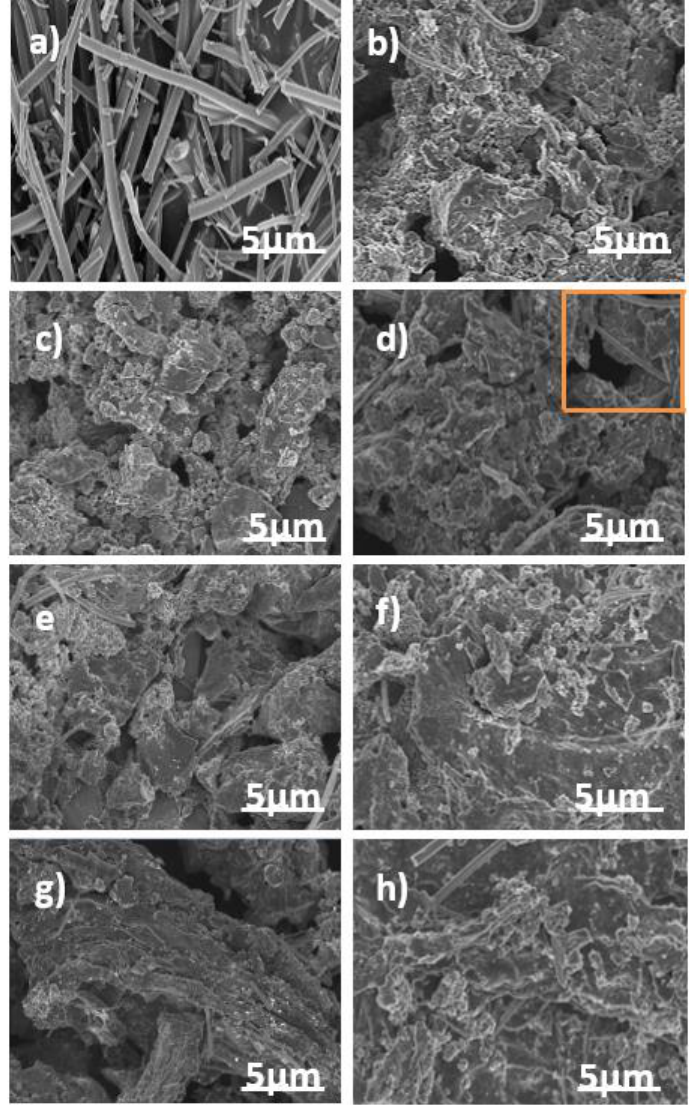
Figure 3. FESEM top view images of ( a ) TiO 2 NF ( b ) AC ( c – h ) ACTiO 2 NF – x, where (x = 0.5, 1.0, 1.5, 2.0, 2.5 and 5.0 wt.% TiO 2 NF)